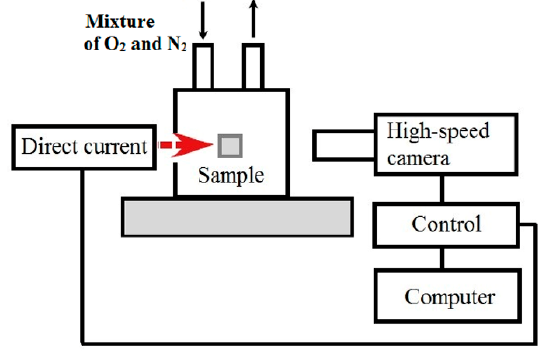
Figure 2. Schematic view of the burning experimental setup.